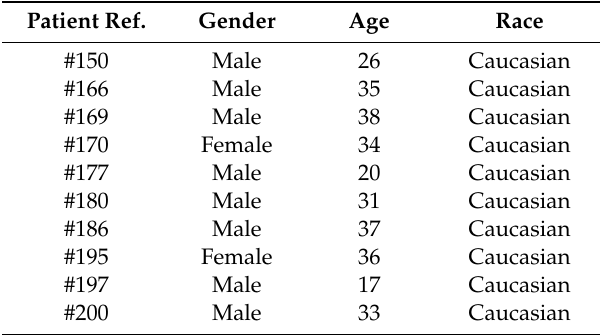
Table 1. Basic clinical characteristics of our donor